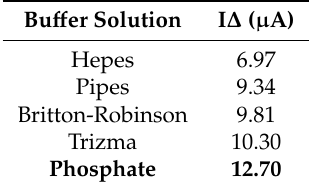
Table 3. Influence of different buffer solutions 0.1 mol L −1 pH 7.0 on the current variation (ΔI) of